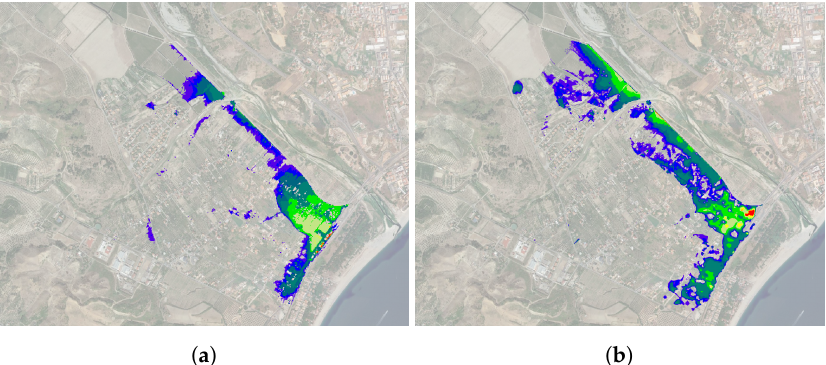
Figure 10. Map of the flooded area predicted by the SWMM ( a ) and MIKE ( b ) models using the synthetic hyetograph “S” in the Corace torrent (Calabria, Southern Italy).